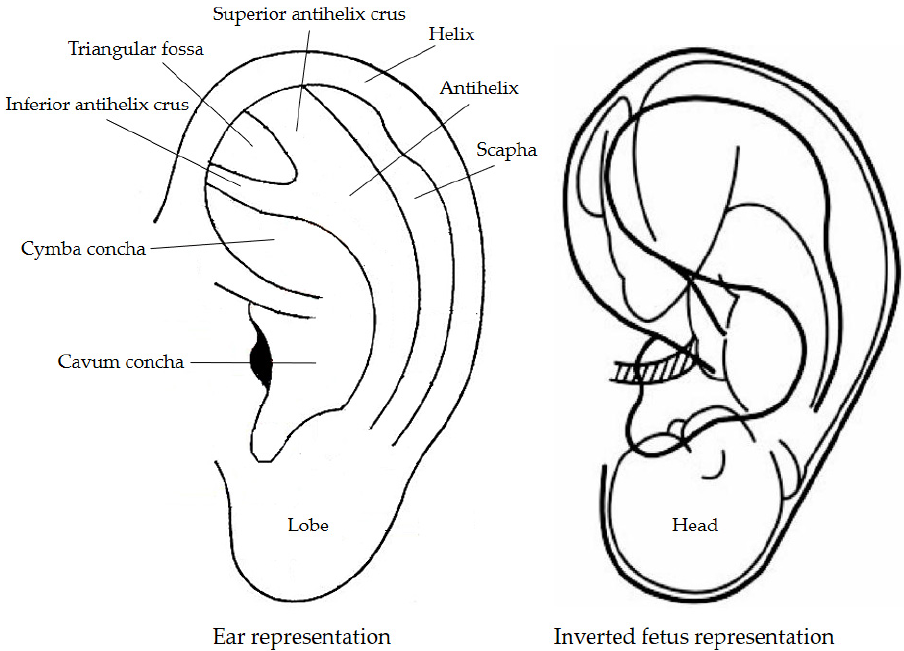
Figure 6. Representation of some regions considered in ear acupuncture and the relation to the inverted fetus representation. Reprinted from ref. [65,66].